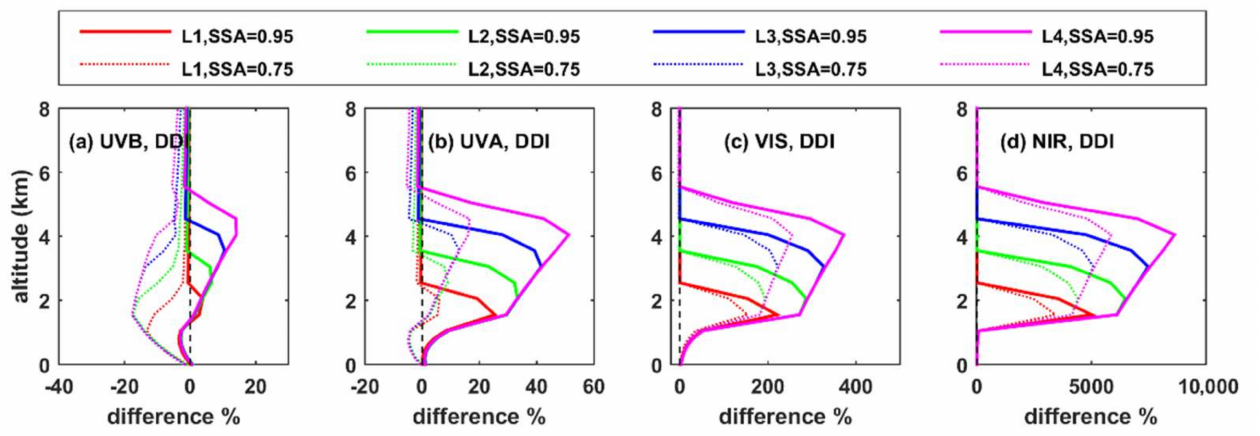
Figure A7. Same as Figure 4, but for AOD = 0.5 instead of AOD = 1.